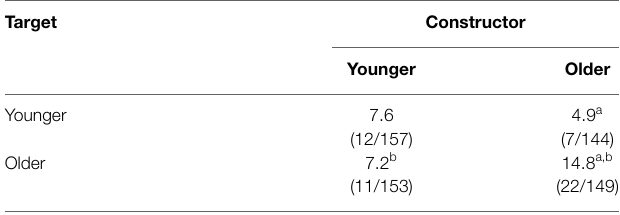
TABLE 1 | The advantage of older constructors creating composites of older target